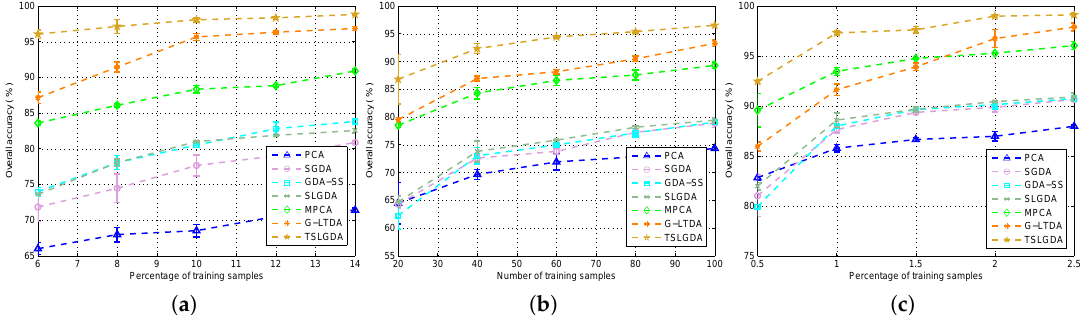
Figure 8. Overall classification accuracy and standard deviation versus different numbers of training samples per class for all methods using three datasets: ( a ) Indian Pines; ( b ) University of Pavia; ( c ) Salinas.